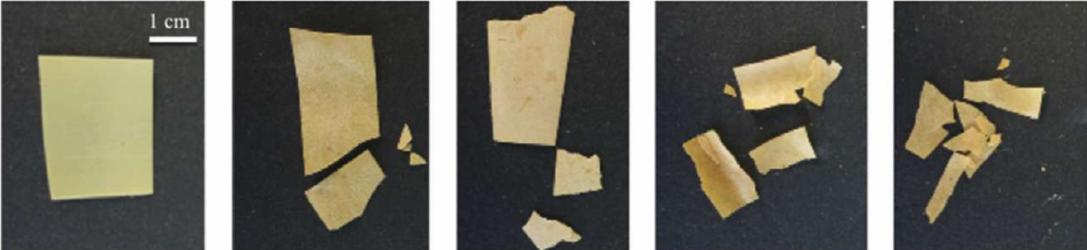
Figure 24. Pictures of the polymeric films recovered after 21 days of incubation in compost. From the left to the right: PBF, P(BF90BDG10), P(BF80BDG20), P(BF70BDG30), and P(BF60BDG40) [77]. PEG is another linear polymer that can provide other polyesters with